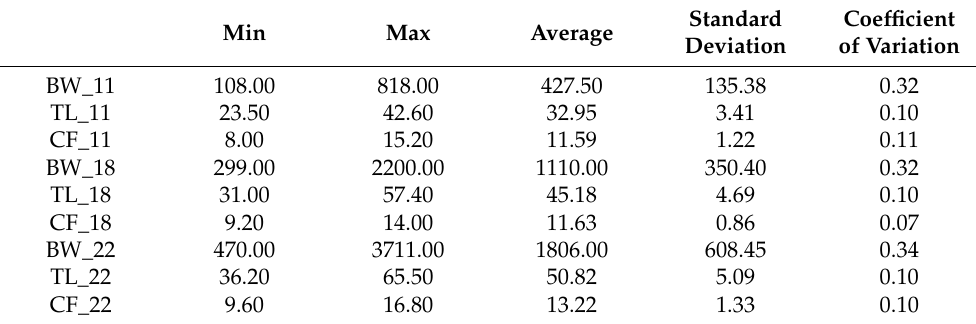
Table 1. Descriptive statistics for olive flounder ( Paralichthys olivaceus ): BW, TL, and CF traits in 3 periods of time.